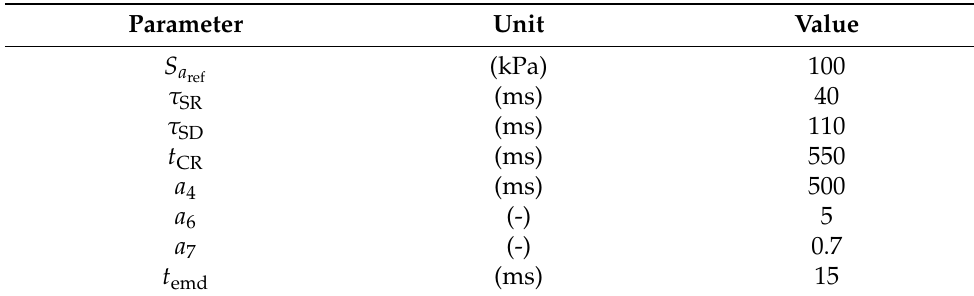
Table A1. Parameters of the Tanh model